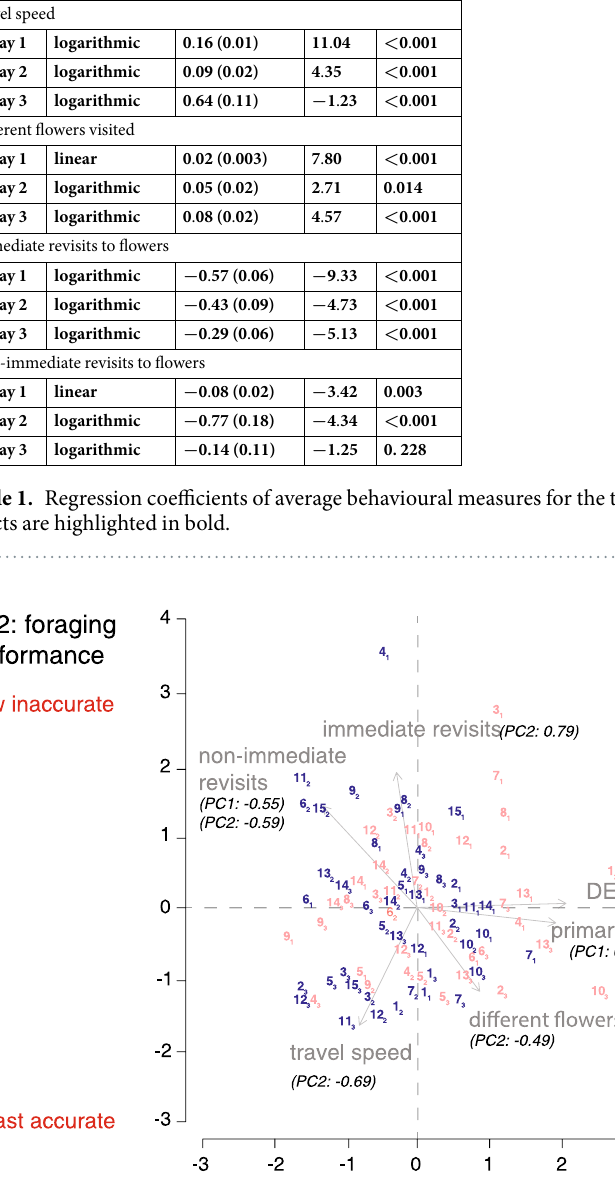
extremes (Fig. 3): fast accurate and regular route followers (high PC1/low PC2 scores), fast accurate and irregu- lar route-followers (low PC1/low PC2 scores), slow inaccurate and regular route-followers (high PC1/high PC2 scores), and slow inaccurate and irregular route-followers (low PC1/high PC2 scores). While foragers of colony 2